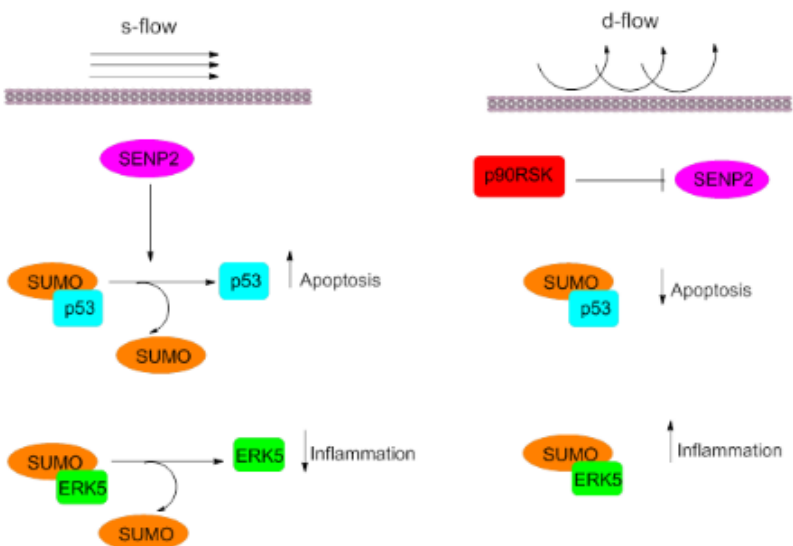
Figure 2. Pro-atherogenic effects of d-flow on inflammation and apoptosis in the p90RSK-dependent pathway. In the steady-state (s-flow), SENP2 enzyme deSUMOylate p53, and ERK5, which are key regulators of inflammation and apoptosis in ECs. Activation of p90RSK, as a result of disturbed flow (d-flow) leads to SENP2 enzyme inhibition. p53 and ERK5 remain in the SUMOylated form, which exacerbates inflammatory conditions and promotes cell proliferation following a decrease in the rate of apoptosis.